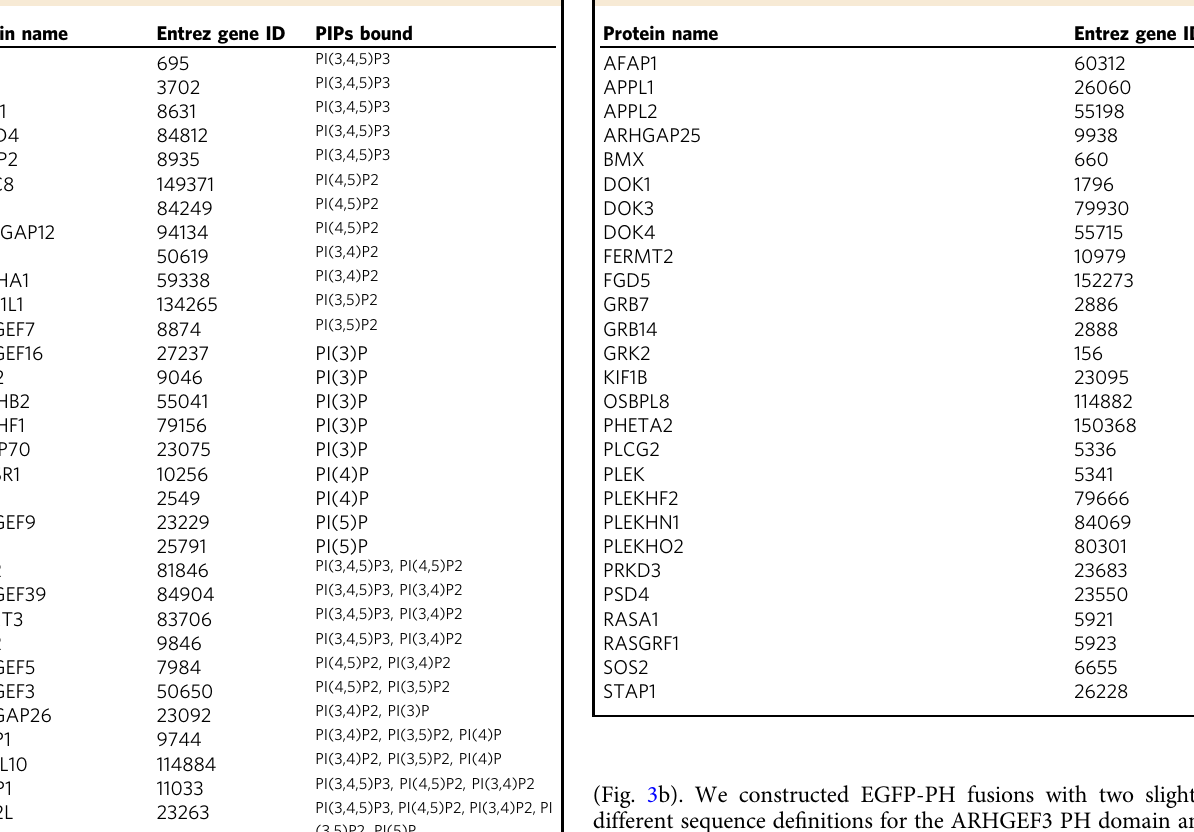
Table 2 PH domain-containing proteins found to not bind any PIP in the initial lipid-SiMPull